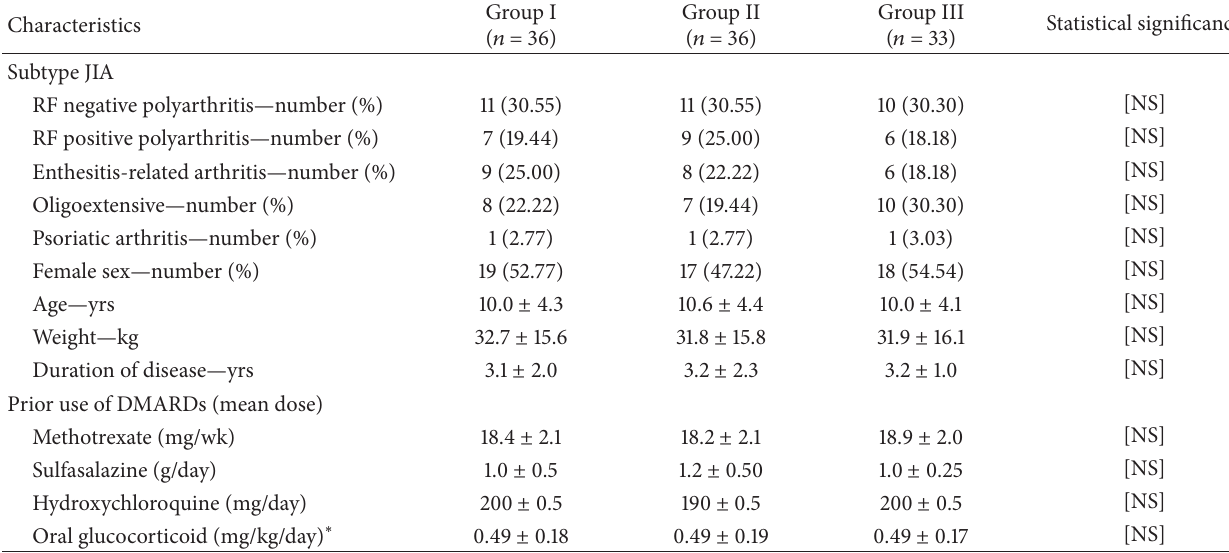
Table 1: Baseline demographic and clinical characteristics of the JIA patients at the initiation of the study.